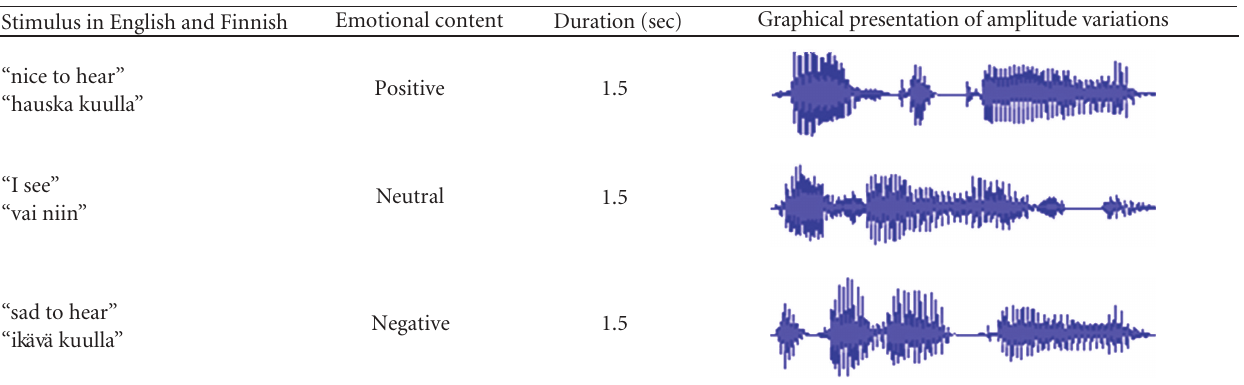
Table 3: The stimulus parameters varied in the